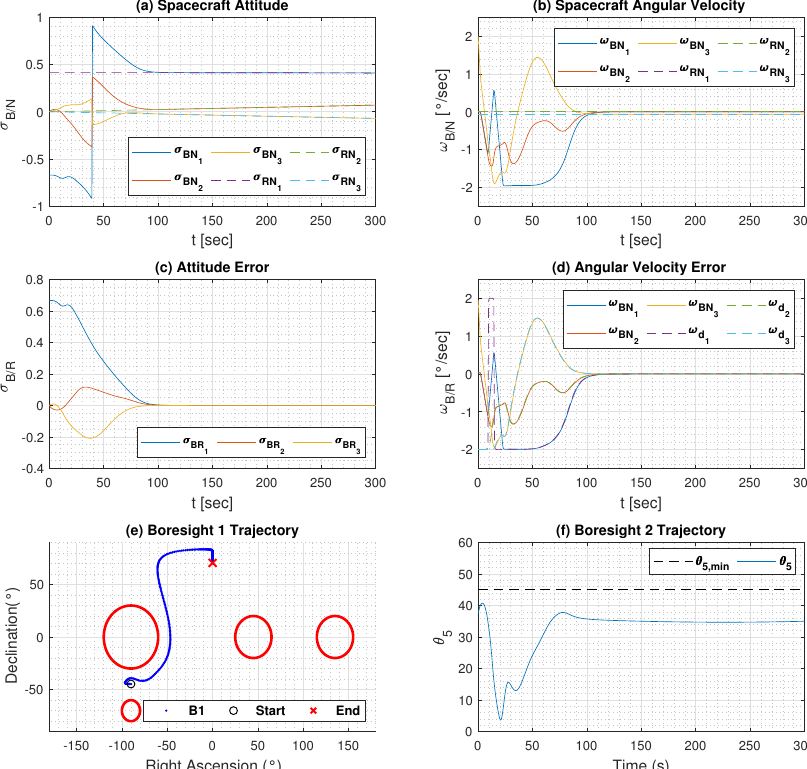
Figure 20. Tracking Performance with Dynamic Inclusion Constraint described by Equation (54). A γ = 1.5 was used for the dynamic constraint, or half of ω z current angular velocity. The spacecraft is unbounded in torque. ( a ) is the spacecraft attitude history, ( b ) is the angular velocity history, ( c ) is the attitude error, ( d ) is the angular velocity error, ( e ) is the trajectory of boresight 1, and ( f ) is the angle history of boresight 2.